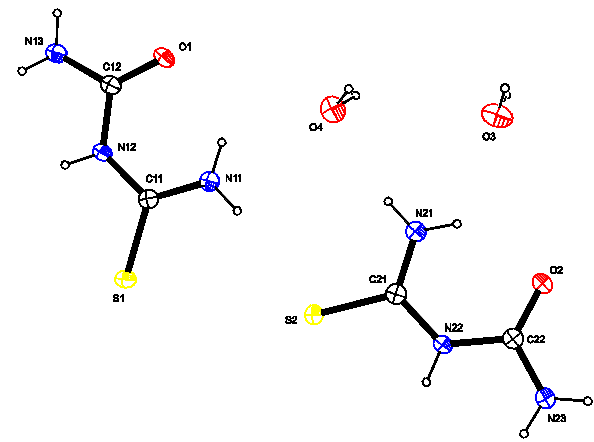
Figure 4: An ORTEP view of (carbamoylamino) methanethioamide ( III) shows 50% probability displacement ellipsoids and the atom